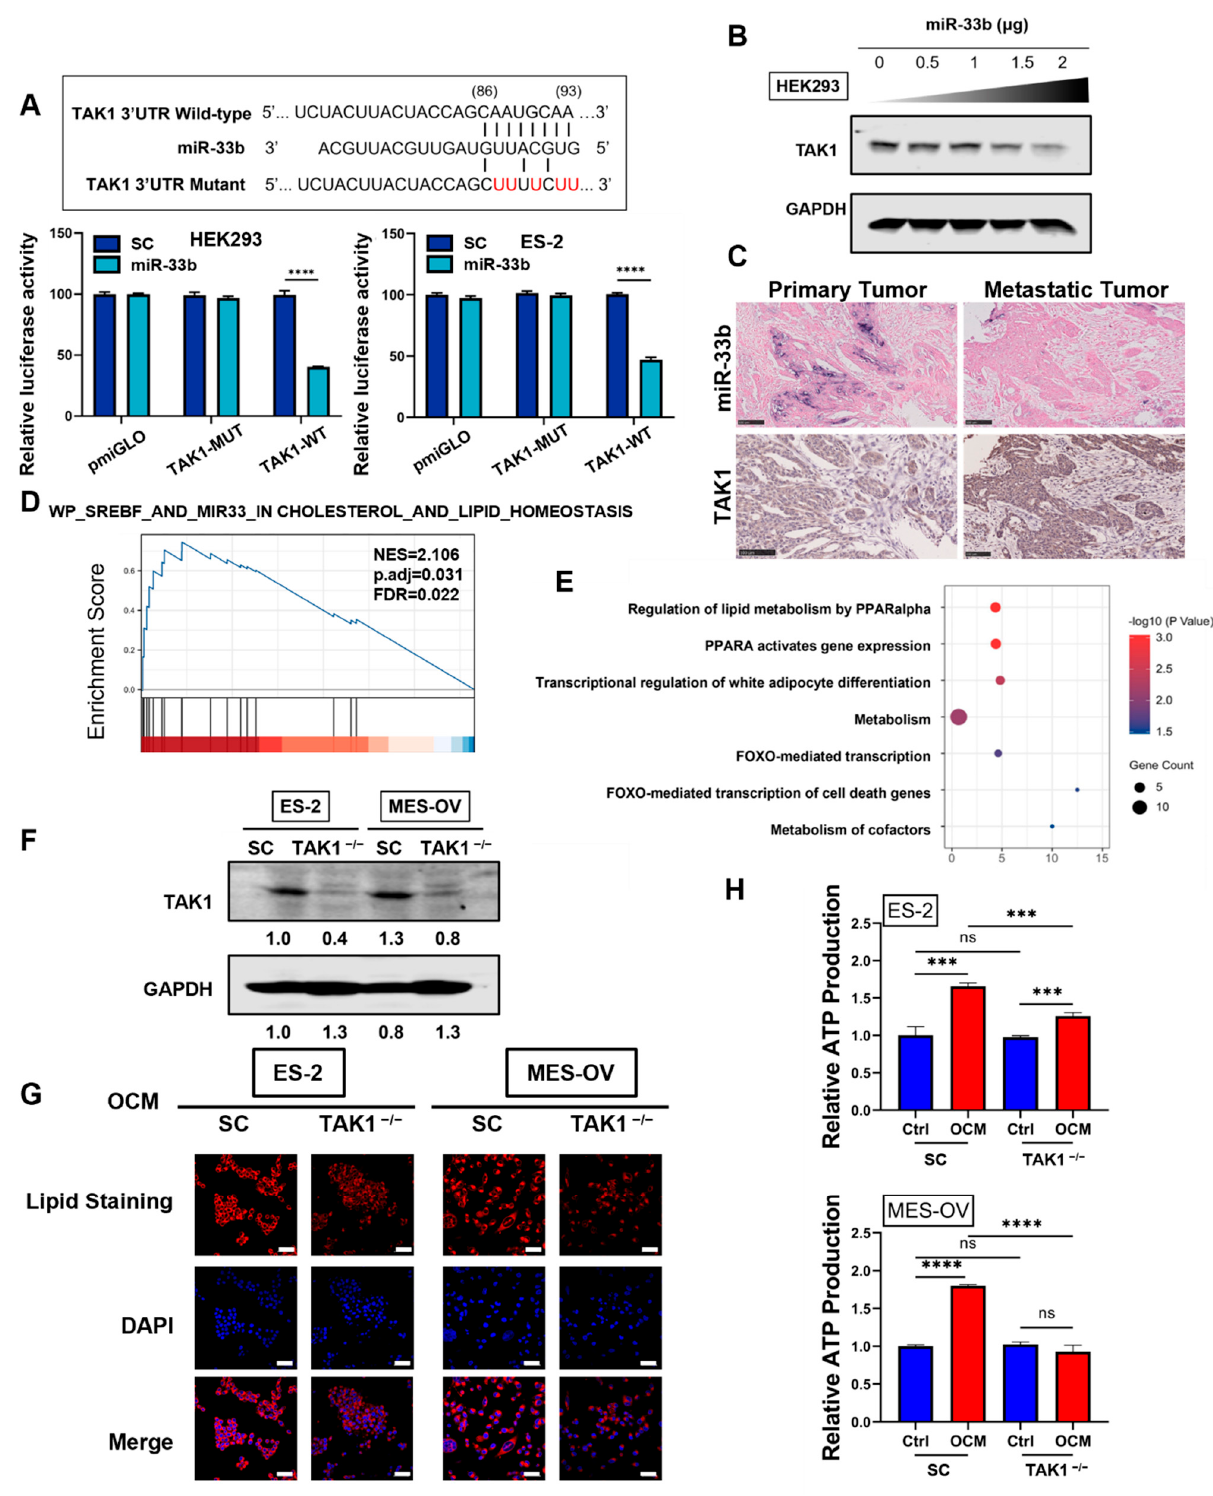
Figure 4. TAK1, a direct target of miR-33b, is associated with lipid metabolism of ovarian cancer cells. ( A ) Schematic representation of putative miR-33b binding site in wild-type or mutant TAK1 3 ′ UTR (upper panel). Luciferase reporter activity in HEK293 or ES-2 cells co-transfected with wild-type or mutant 3 ′ UTR TAK1 constructs with pCMV-miR33b plasmid or scrambled control was determined by the Dual-Luciferase ® Reporter Assay System (lower panel). ( B ) HEK293 cells were transfected with different amounts of pCMV-miR33b plasmid for 48 h, and TAK1 expression was measured using western blot analysis. ( C ) Representative micrographs depicting the primary ovary carcinoma with matched meta- static carcinoma tissue array (OV812) stained for miR-33b by in-situ hybridization (ISH) and TAK1 by